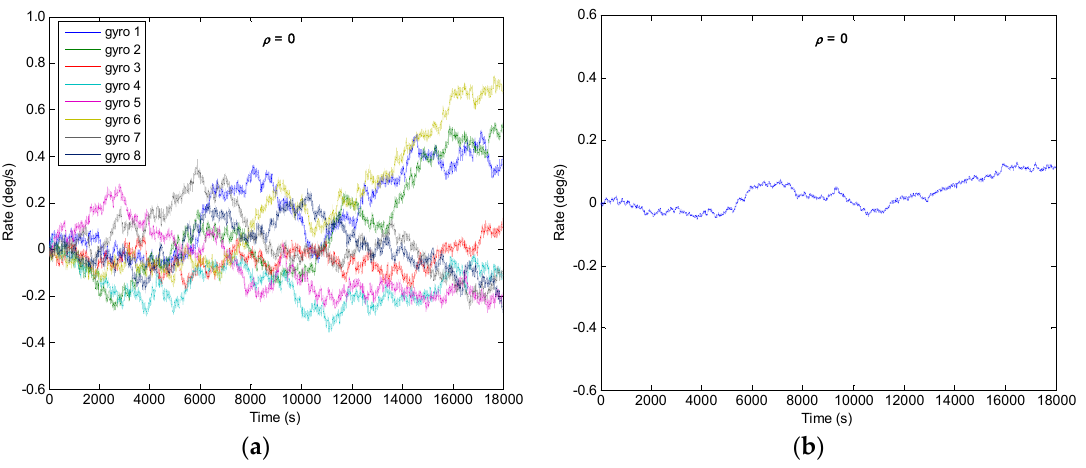
Figure 5. Filtering result of gyroscope array with ρ = 0: ( a ) Outputs of component gyroscopes; ( b ) Output of combined gyroscope.